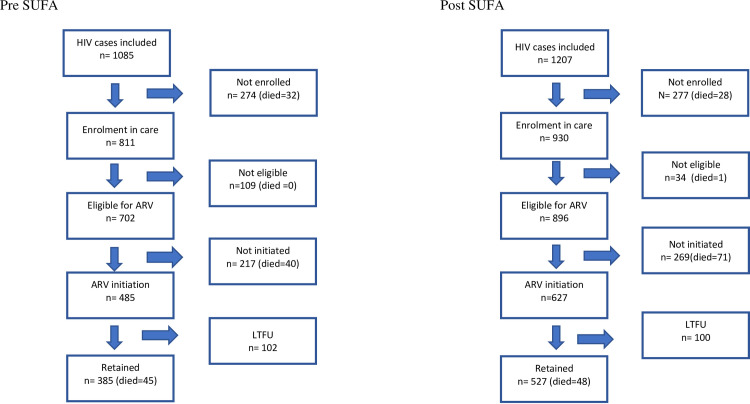
Flow diagram of data collection for cohort population, stratified pre-and post-SUFA.